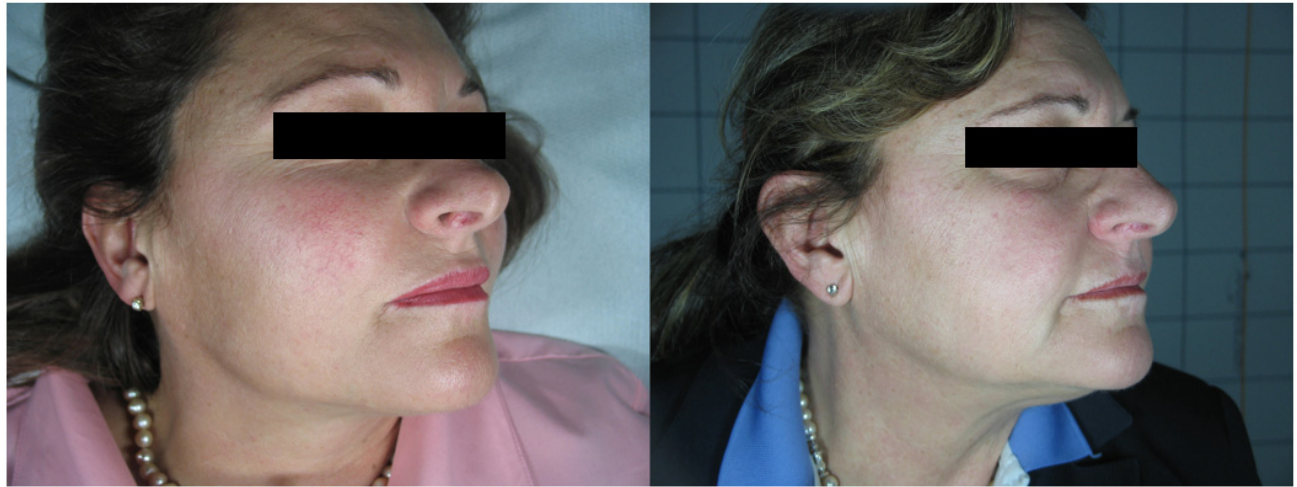
Figure 4. Patient n. 34 before (left) and 3 months after IPL treatment.